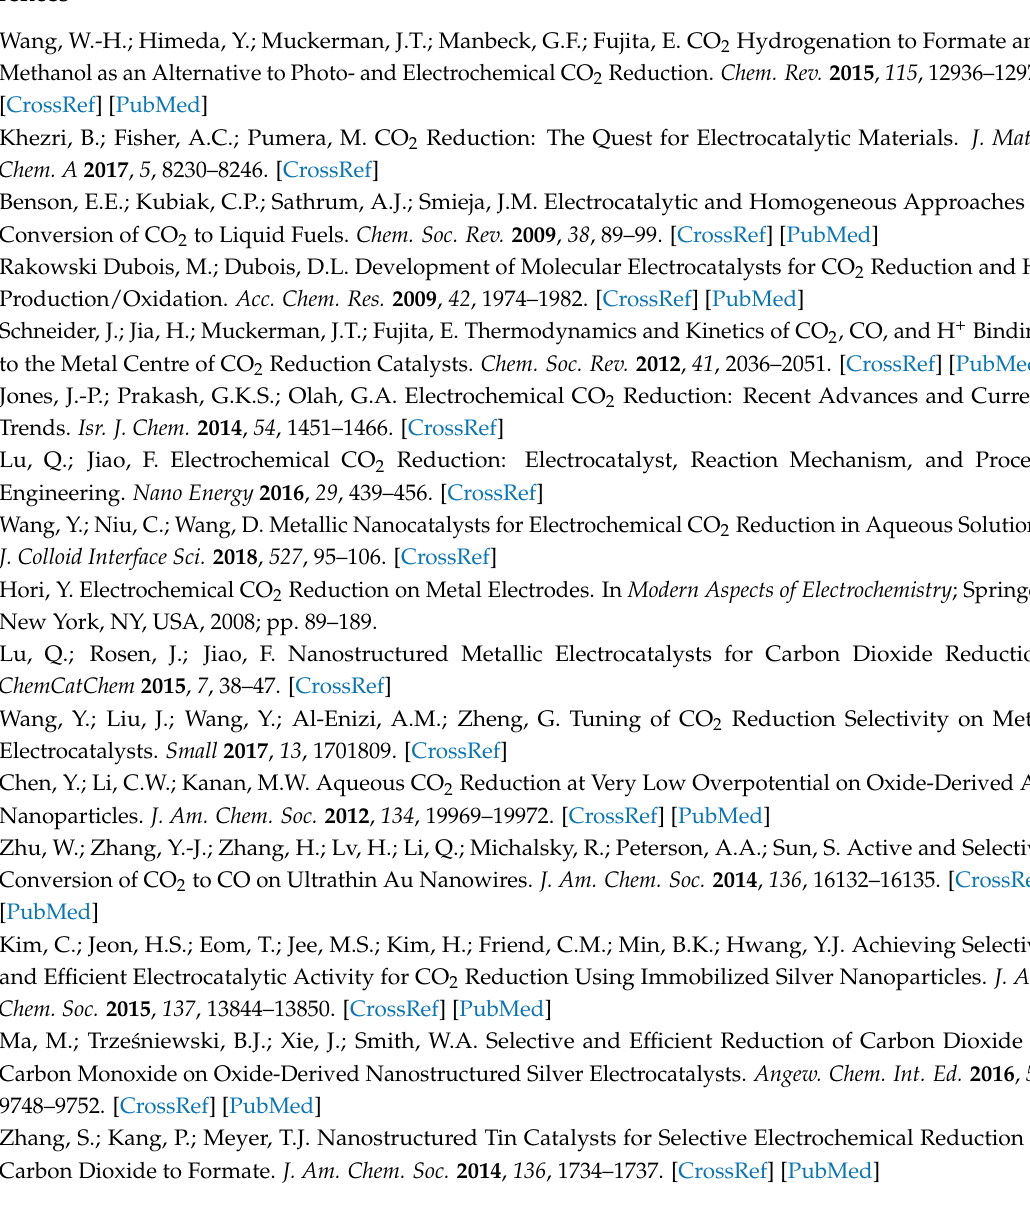
CO 2 reduction of the Cu mesh and the Cu–Ag mesh. Figure S9: CO 2 reduction activity on the Cu mesh and the Cu–Ag mesh at different potentials. Figure S10: FE of the major products for the Cu mesh and the Cu–Ag mesh at − 0.6 V (vs. RHE). Figure S11: FE of the major products for the Cu mesh and the Cu–Ag mesh at − 0.7 V (vs. RHE). Figure S12: FE of the major products for the Cu mesh and the Cu–Ag mesh at − 0.8 V (vs.